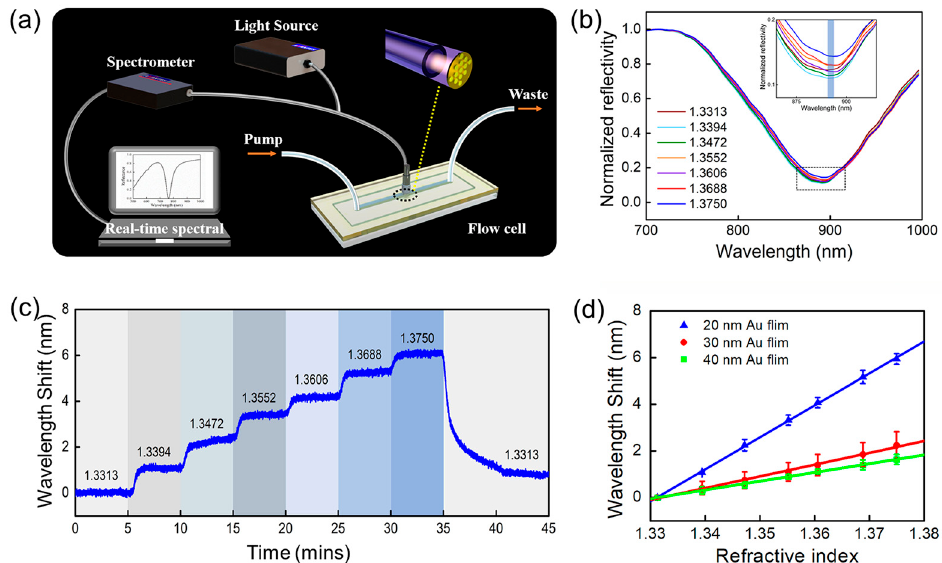
Figure 4. The quantitate evaluation of bulk RI sensitivity of the proposed nanodisk array/thin film-based fiber probe. ( a ) Schematic of experimental measurements setup for evaluating sensing performance of the proposed plasmonic fiber probe. ( b ) Normalized reflection spectra of the proposed Au nanodisk array/20 nm thick film-based fiber probe in the NaCl solution with RIs ranging from 1.3313 to 1.3750. ( c ) Wavelength redshift amount of resonant dip for different RIs of NaCl solution as a function of time. ( d ) Relationship between wavelength redshift amount of resonance dip and ambient RIs for Au thin film’s thickness of 20 nm, 30 nm, and 40 nm. Uncertainties in ( d ) are based on the results of three repeated measurements for every experimental data